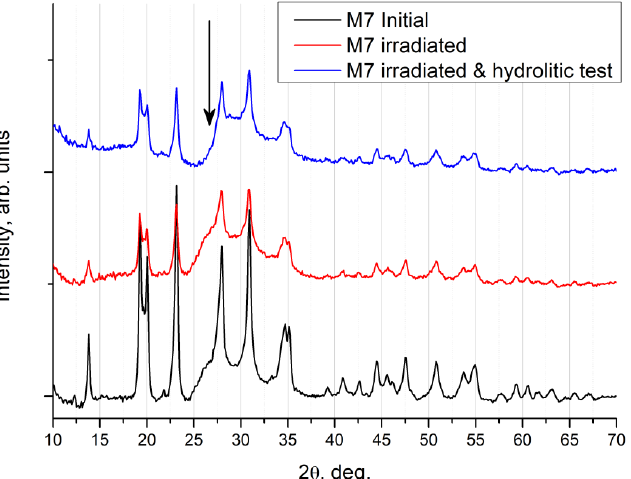
Figure 11. XRD patterns for the Na 0.5 Zr 2 (PO 4 ) 2.5 (MoO 4 ) 0.5 ceramic specimen: initial state, irradiated with Xe ions at a dose of 6·10 13 cm -2 , and after hydrolytic tests. The Na 0.5 Zr 2 (PO 4 ) 2.5 (MoO 4 ) 0.5 ceramics after hydrolytic tests showed no change in